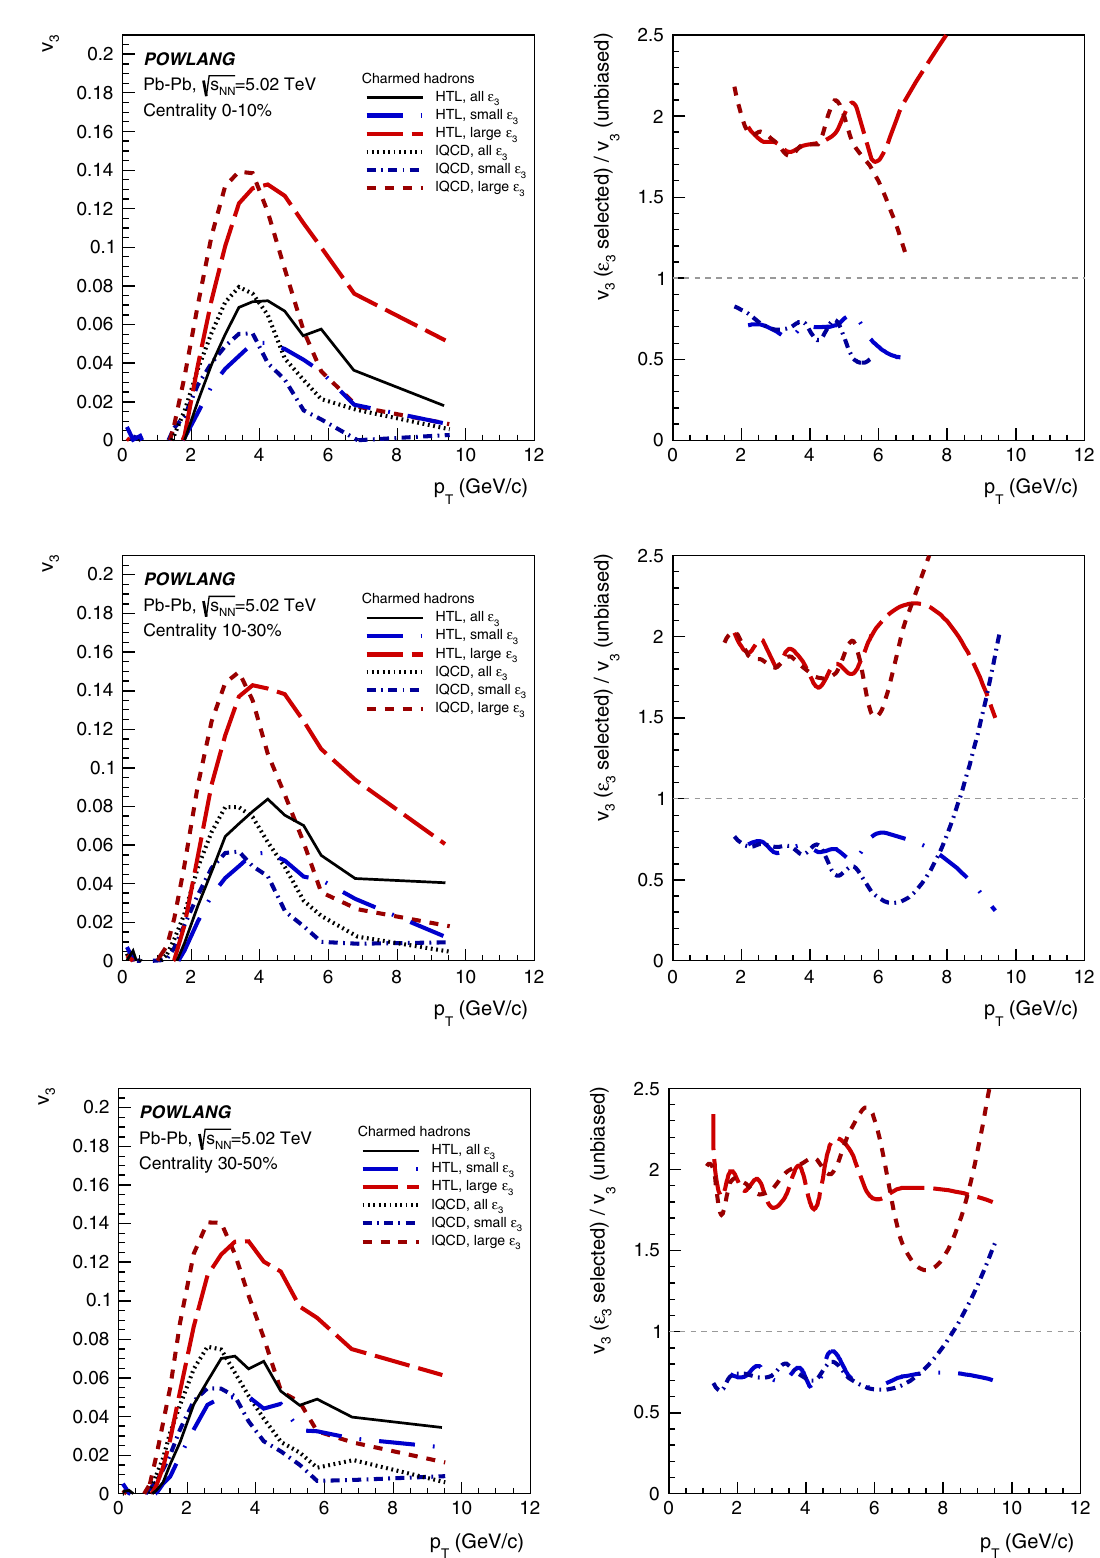
Fig. 13 The triangular-flow coefficient v 3 of charmed hadrons in the 0–10% (top), 10–30% (middle) and 30–50% (bottom) most central Pb– √ s NN = 5 . 02 TeV. Results for the 20% highest- (cid:7) 3 and Pb collisions at